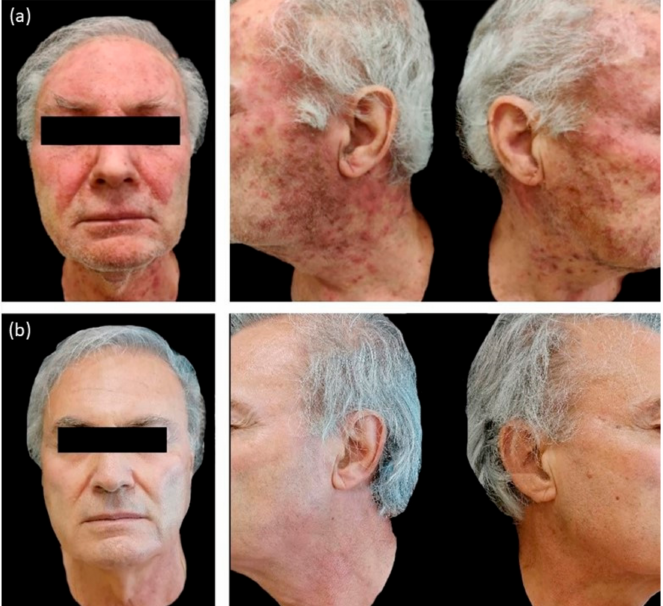
Figure 4. ( a ) Baseline pictures showing a papulopustular eruption of the face and neck due to Epidermal Growth Factor Receptor inhibitors (EGFR inhibitors). ( b ) Same patient after 4 weeks of treatment with polydatin 1.5%